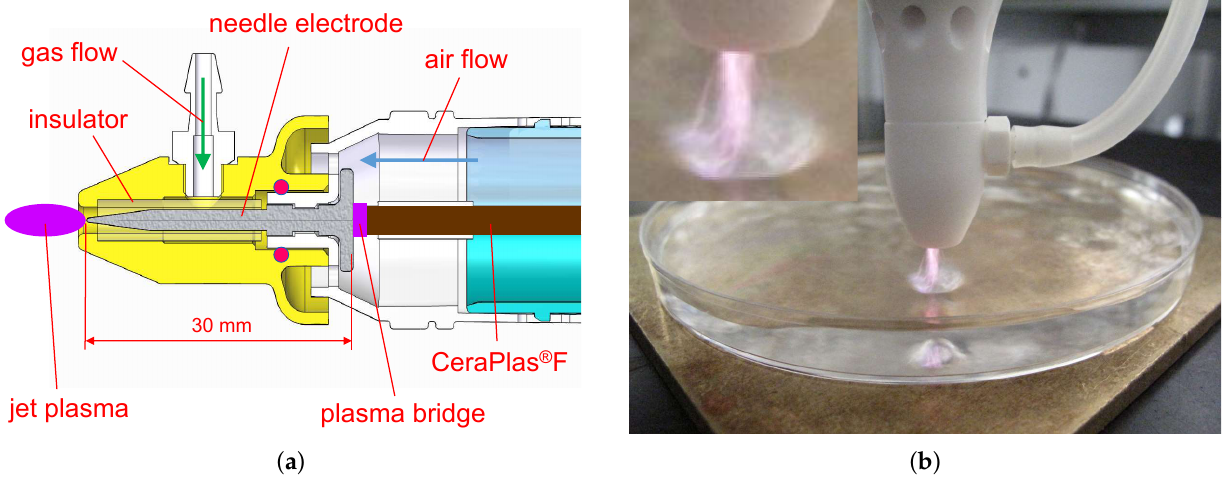
Figure 21. The multi-gas nozzle ( a ) operation principle, and ( b ) of the piezobrush ® PZ2 treating